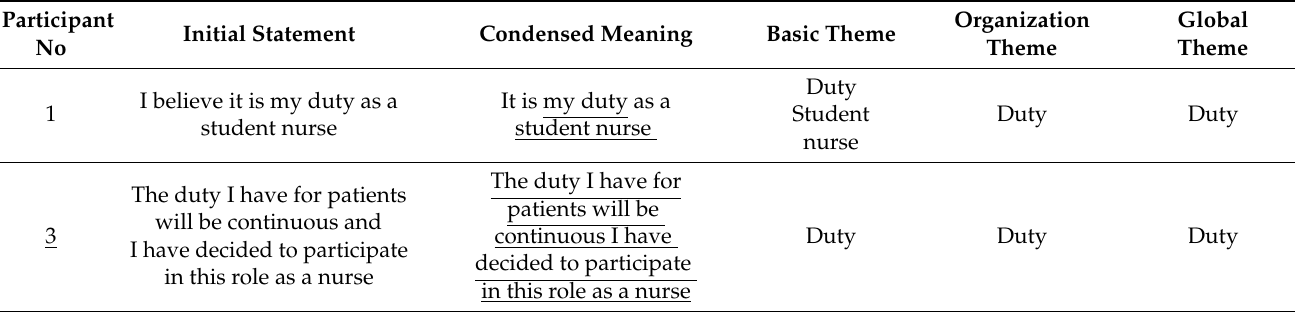
Table 2. Transcript analysis and theming associated with